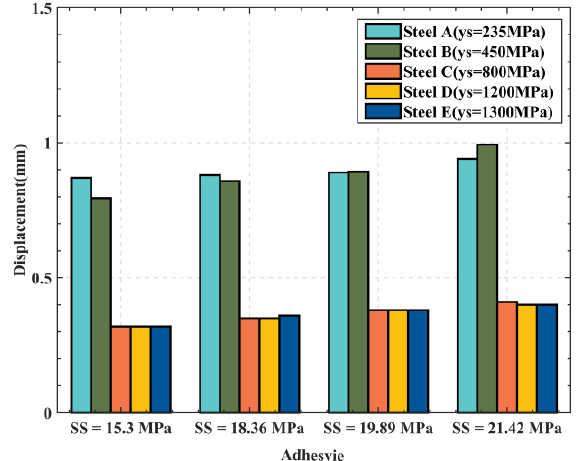
Figure 16. Failure load of different anchorage system.